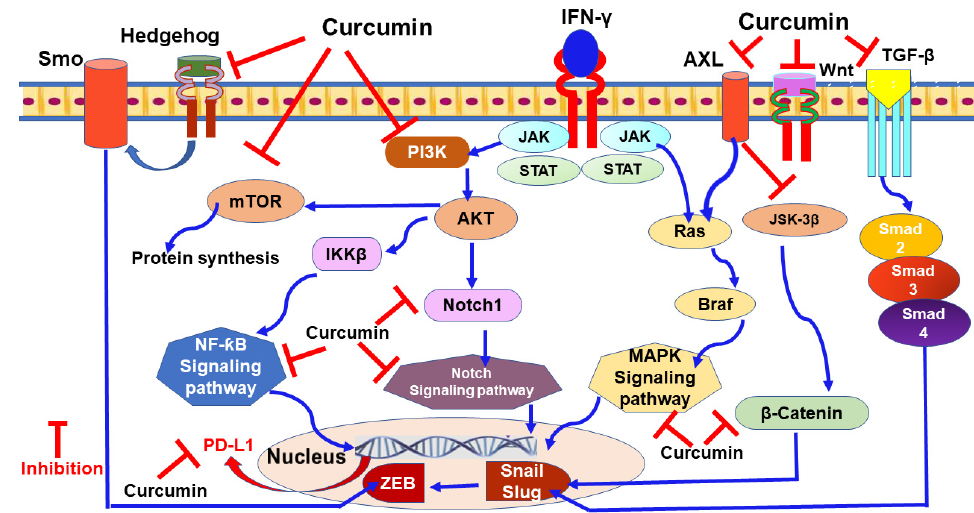
Figure 3. The mechanism of curcumin-mediated programmed death-ligand 1 (PD-L1) inhibition in breast cancer cells. Signal transducer and activator of transcription, STAT; Janus kinase, JAK; nuclear factor-kappa β , NF- κ B; smoothened, frizzled class receptor, Smo; interferon-gamma, IFN- γ ; Phosphoinositide 3-kinase, PI3K; protein kinase β , AKT; mammalian target of rapamycin, mTOR; mitogen-activated protein kinase, MAPK; B-raf serine/threonine-protein, Braf; rat sarcoma, Ras; transforming growth factor- β , TGF- β ; mothers against decapentaplegic, Smad; wingless-related integration site, Wnt; zinc finger E-box binding homeobox, ZEB; snail family transcriptional repressor, Snail; inhibitor of kappa light polypeptide gene enhancer in β -cells, kinase beta, IKK β ; programmed death-ligand 1, PD-L1; AXL receptor tyrosine kinase, AXL.